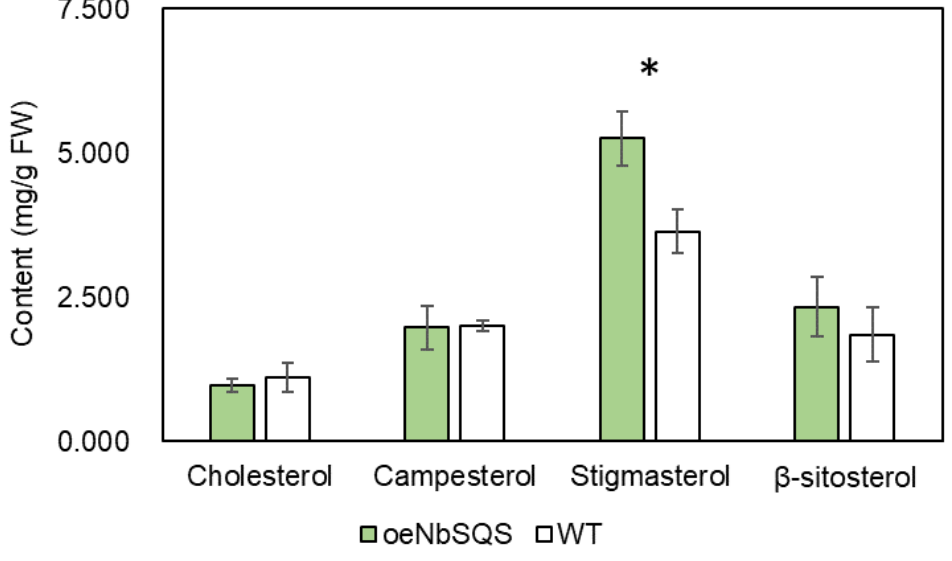
Figure 5. Quantification of phytosterols in wild type and SQUALENE-SYNTHASE -overexpressing N. benthamiana leaves. N = 3 for either genotype; error bars = standard deviations. * p < 0.05, Student’s t -tests.